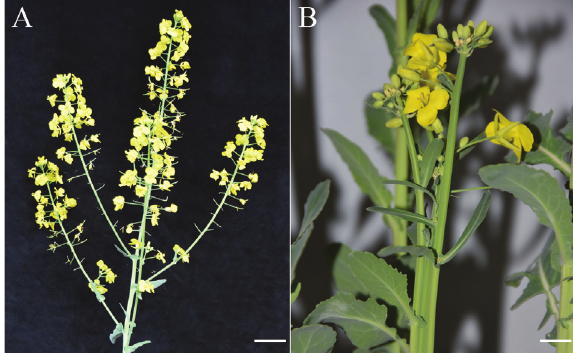
Figure 1 - Inflorescence morphology of wild type (A) and Bnclv-like mu- tant (B) at flowering stage. Bar=10